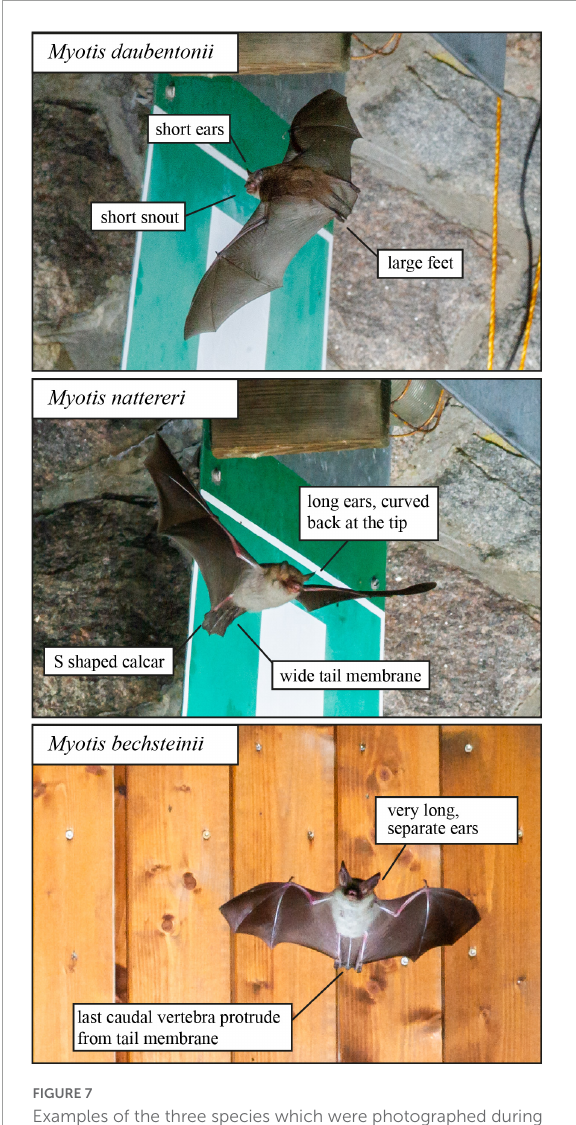
FIGURE7 Examples of the three species which were photographed during the playbacks. Features used for species identification are labeled